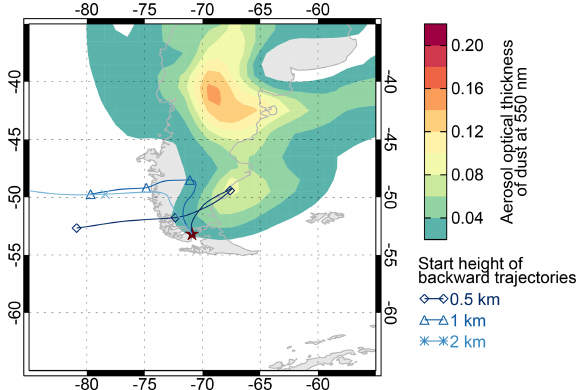
Figure 4. HYSPLIT 48h backward trajectories for heights of 0.5, 1 and 2km for Punta Arenas on 2 March 2010, 09:00UTC, and mod- elled dust surface concentrations from the NAAPS aerosol model on 2 March 2010, 06:00UTC.